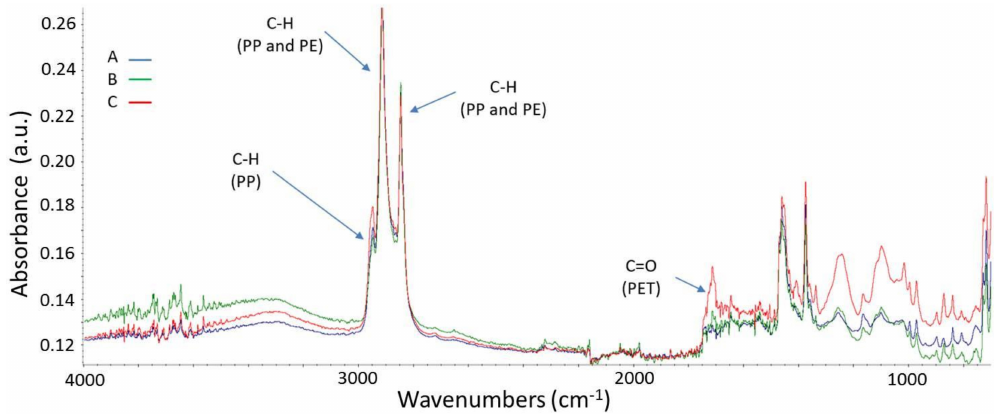
Figure 3. Infrared spectrum analysis of the re-formative polymer (this